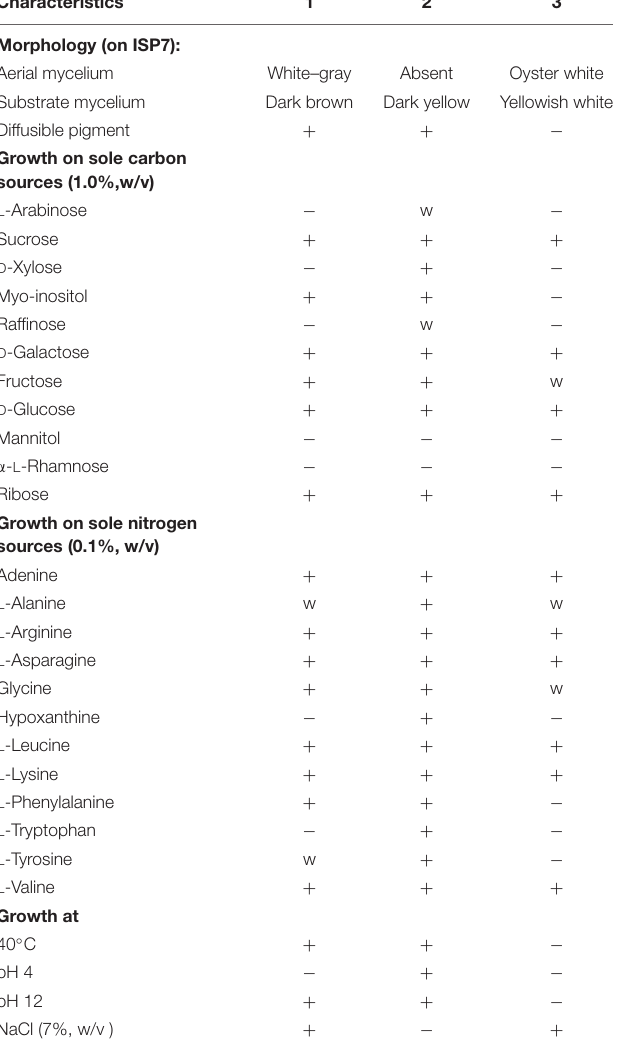
Characteristics